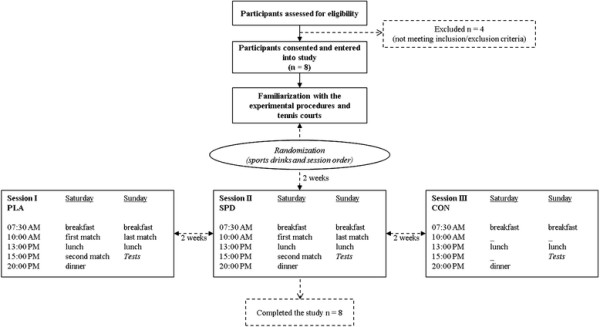
Experimental design and flow diagram of subjects’ passage through the study.